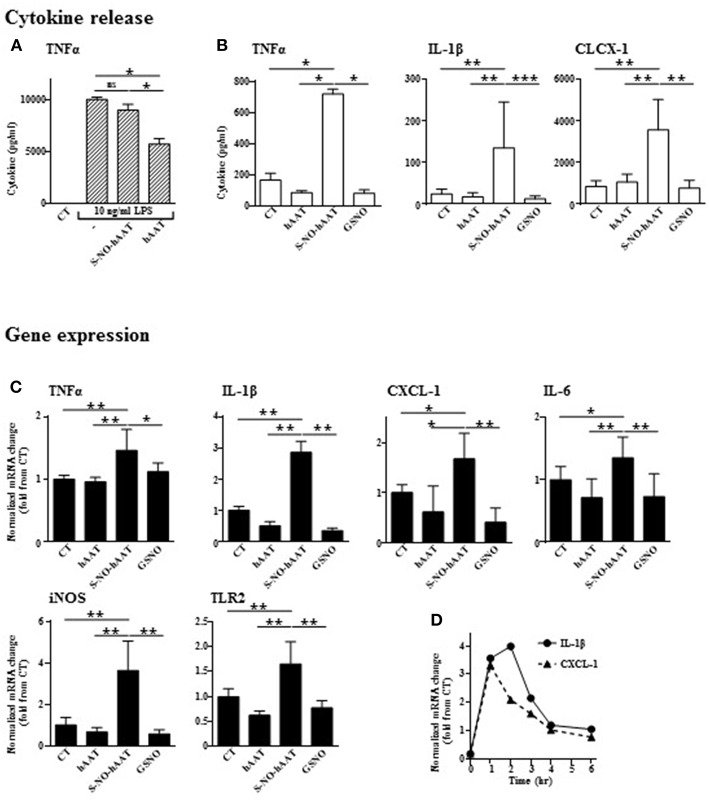
Unlike unmodified hAAT, S-NO-hAAT increases inflammatory responses. Cytokine levels were determined in the supernatants of peritoneal macrophages (0.5 × 106 per well) 48 h post-treatment with equimolar (27.5 μM) S-NO-hAAT, hAAT, GSNO and nitrosylation buffer (CT). (A) 10 ng/ml LPS stimulation 1 h post-treatment (n = 4). (B) S-NO-hAAT, hAAT, and GSNO treatment without added stimulus (n = 4). (C) mRNA relative levels in peritoneal macrophages (0.25 × 106 per well, n = 6 from two independent experiments) 6 h post-treatment with equimolar (27.5 μM) S-NO-hAAT, hAAT, GSNO and nitrosylation buffer (CT). (D) Relative mRNA levels post S-NO-hAAT treatment at indicated time intervals. All data are presented as mean ± SD, *p < 0.05, **p < 0.01, and ***p < 0.001.